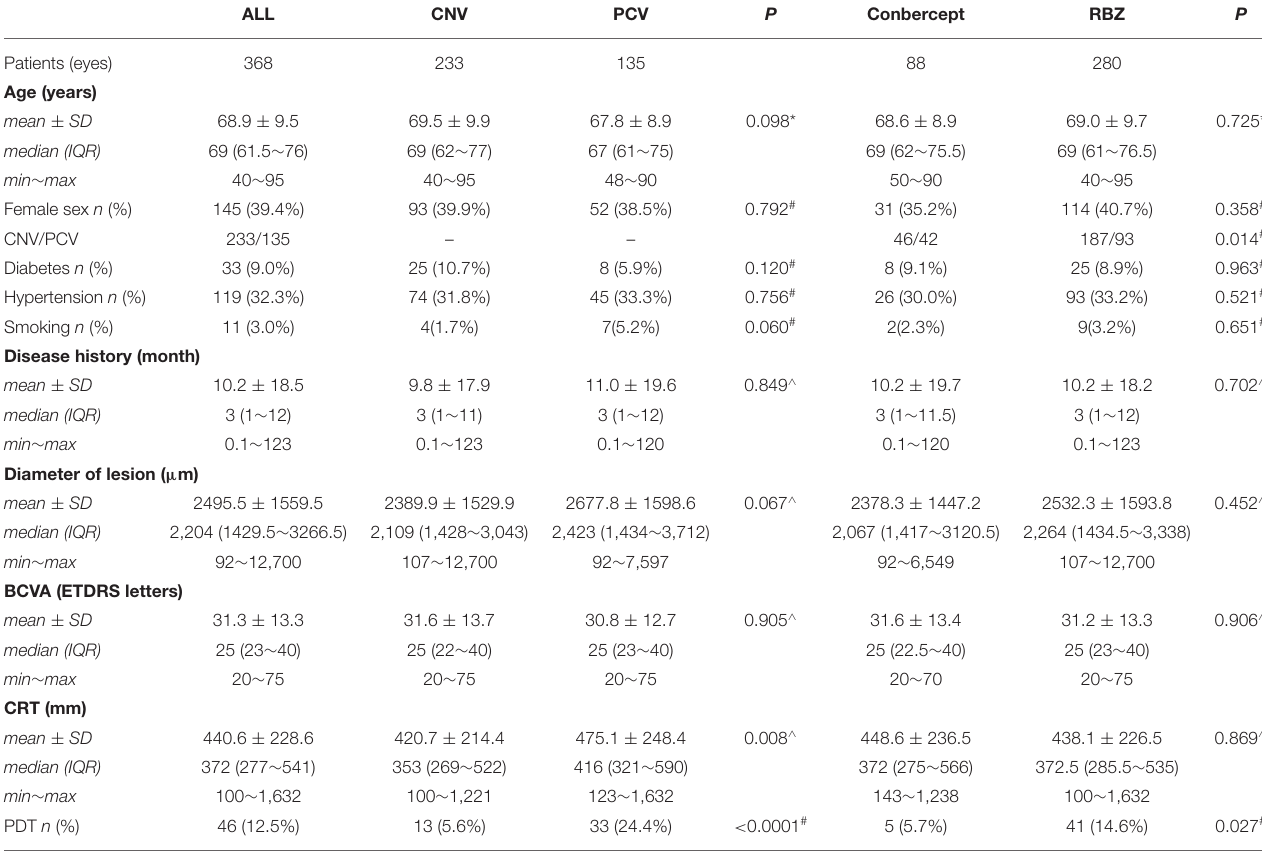
TABLE 1 | Baseline characteristics of all patients.